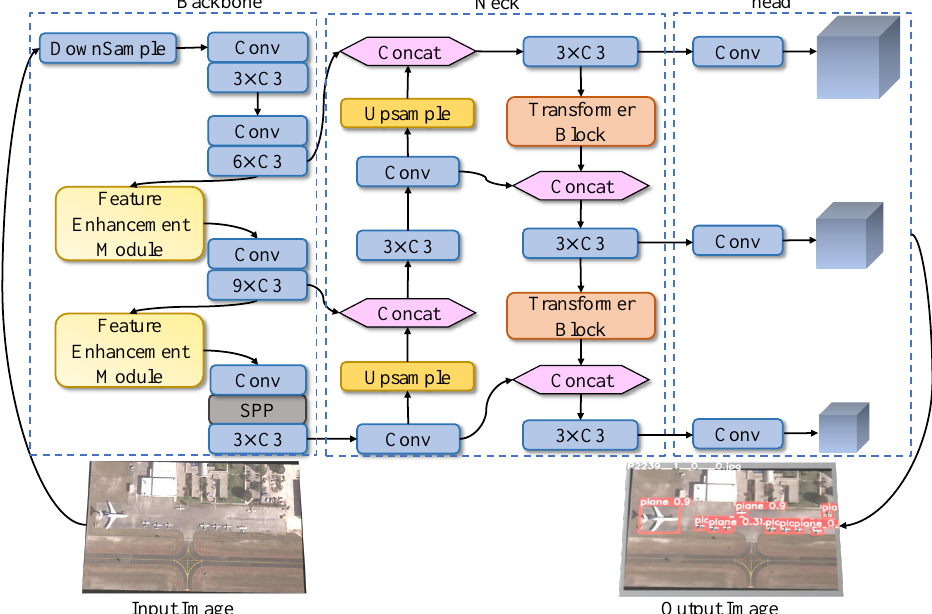
Figure 1. The MDCT framework. We propose a feature enhancement module to improve the features of small objects in the backbone. In addition, we integrate a transformer block to capture the context features of the object in the